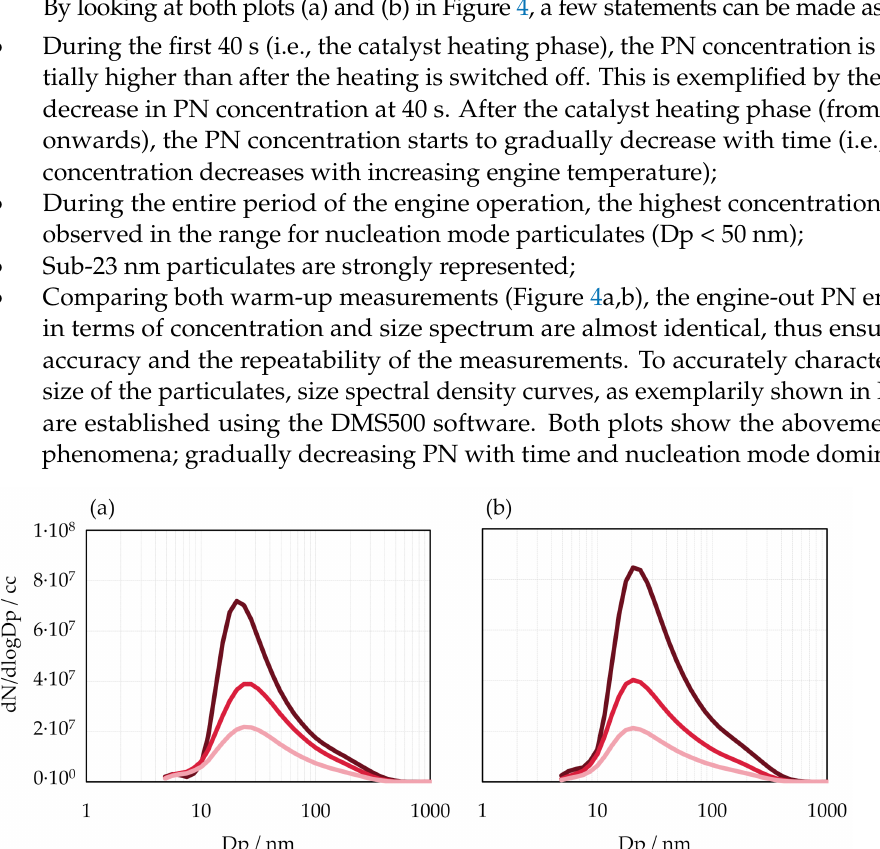
Figure 4. DMS500 contour plots ( a , b ), both representing a cold start at − 15 ◦ C (dTWC sampling). The unit displayed for the PN concentration (dN/dlog dp/cc) is a normalised PN concentration that can be easily converted into a normal concentration (#/cc) using the device’s resolution.